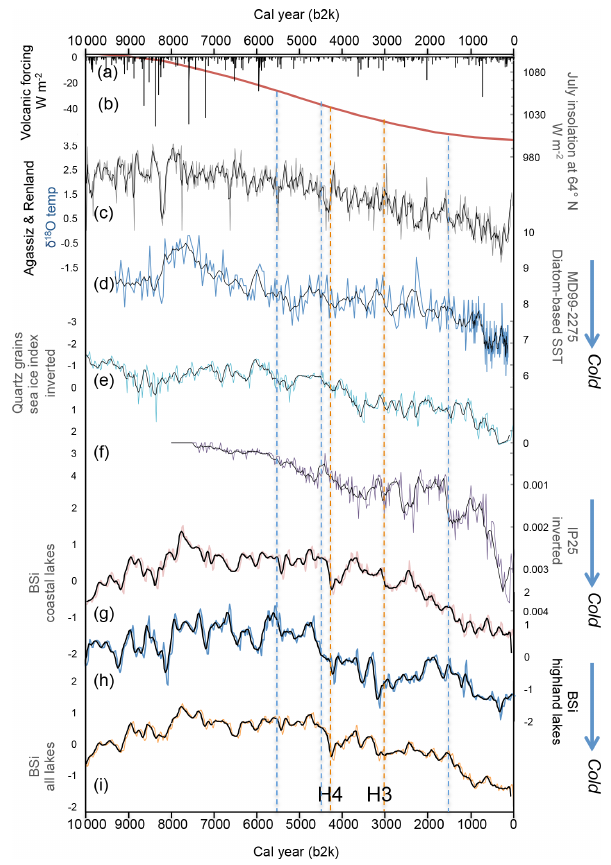
Figure 7. Composite record from all seven lakes compared to (a) 65 ◦ N summer insolation (Berger and Loutre, 1991). (b) Volcanic forcing Wm − 2 (Kobashi et al., 2017), (c) MD99-2275 diatom- based SST (Jiang et al., 2015); (d) Renland–Agassiz ice core record (normalized δ 18 O record and its variance) from Greenland (Vinther et al., 2009); (e) quartz (normalized) from MD99-2269 as an in- dication of sea ice in the northern North Atlantic (Moros et al., 2006); (f) IP25 record of sea ice (Capedo-Sanz et al., 2016); (g) BSi coastal lakes SKR, TRK, TORF, and HAK; (h) BSi highland lakes HVT + ARN; (i) BSi all lakes. Blue hatched lines show the 5.5, 4.5, and 1.5ka steps in the Icelandic lake records. Orange hatched lines show the timing of Hekla 4 and Hekla 3 volcanic